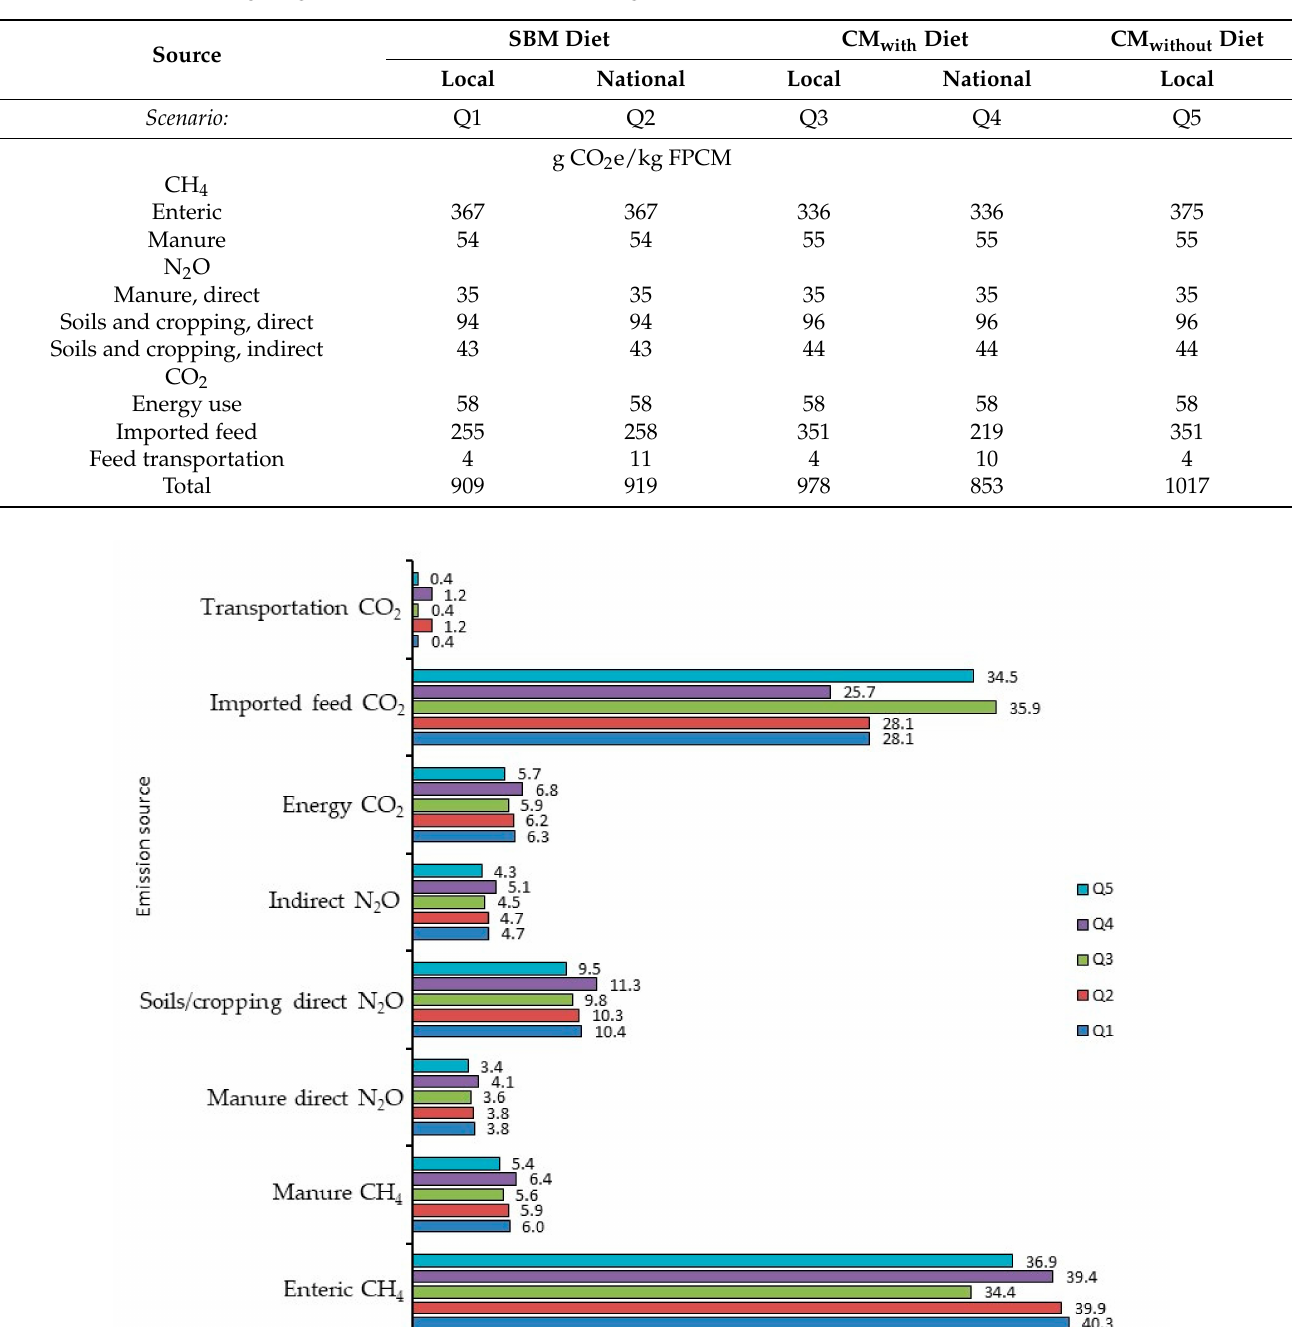
Table 7. Sources contributing to greenhouse gas emission intensity of fat and protein corrected milk (FPCM) for a dairy farm in Quebec using locally and national sourced soybean meal (SBM) or canola meal, with (CM with ) and without (CM without ) enteric methane mitigating effect, in the diets of the lactating cows.